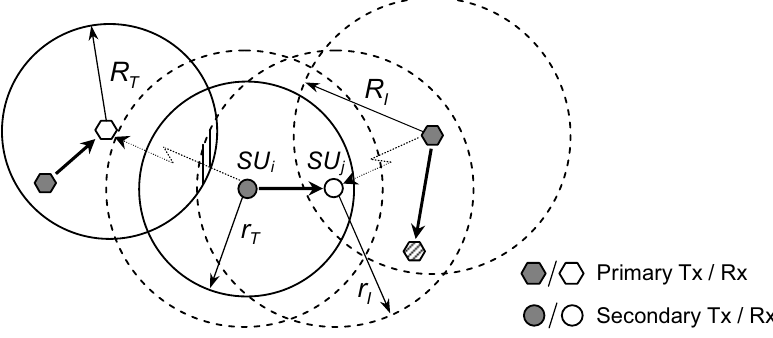
Figure 3. Link connectivity between two adjacent nodes in